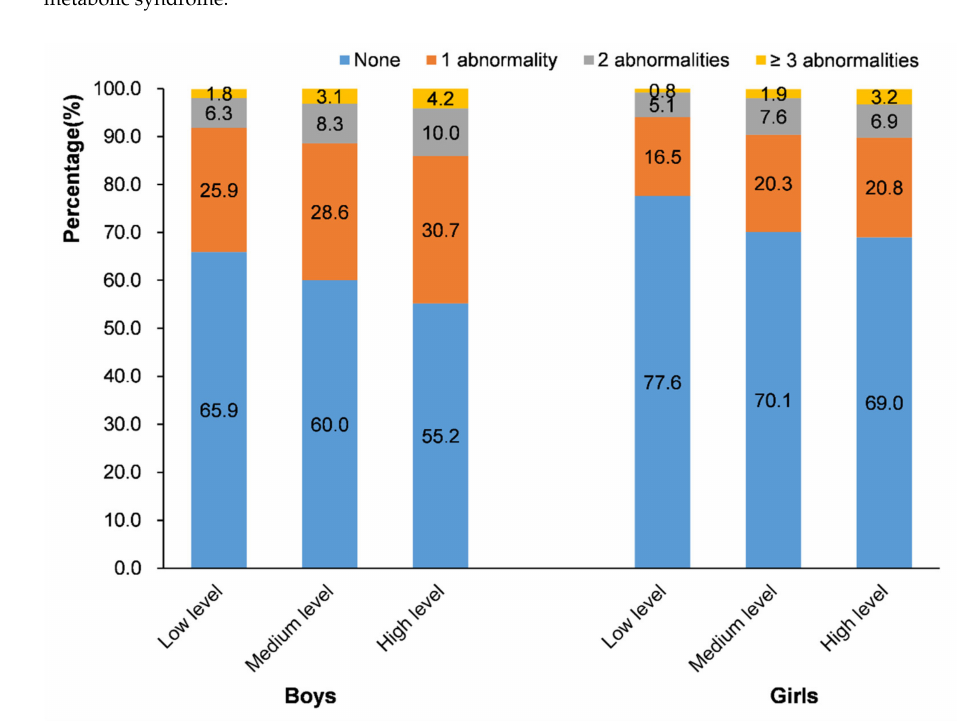
Figure 3. Percentages of people with abnormal numbers of metabolism in different sedentary behavior time groups by